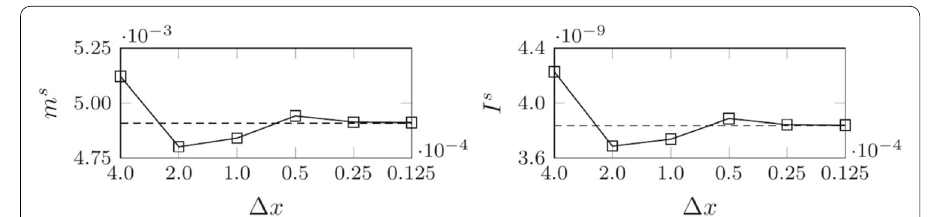
Fig. 5 Spatial discretization of a rigid circular disk: mass m s and mass moment of inertia I s of a rigid circular disk for different values of the initial particle spacing (cid:10) x (solid line) compared to the analytical solution (dashed line)